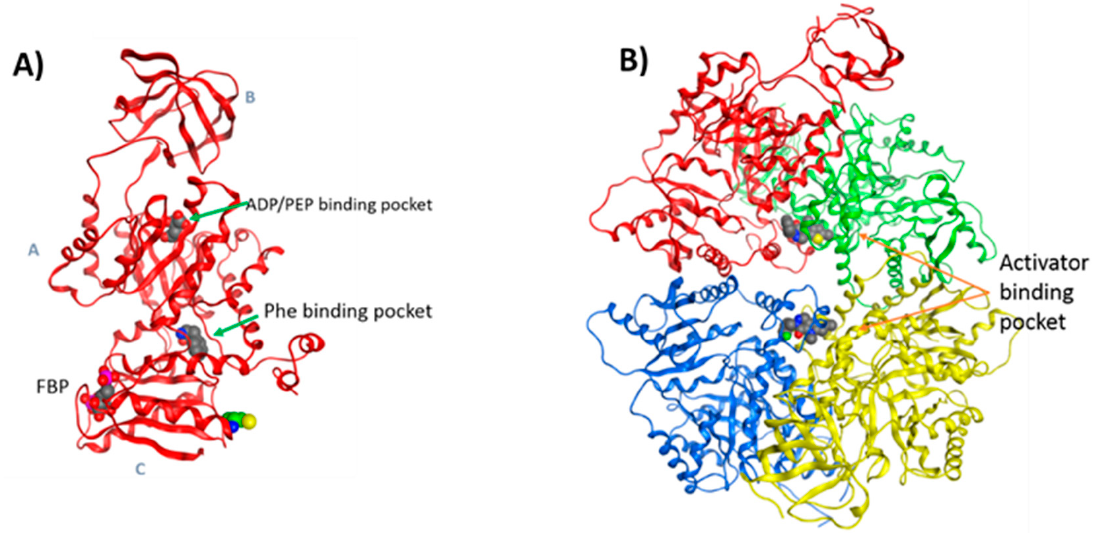
Figure 5. ( A ) Monomeric structure of PKL with different binding sites illustrated. ( B ) PKM2 active tetramer structure with activator binding (PDB ID: 3U2Z) [36].